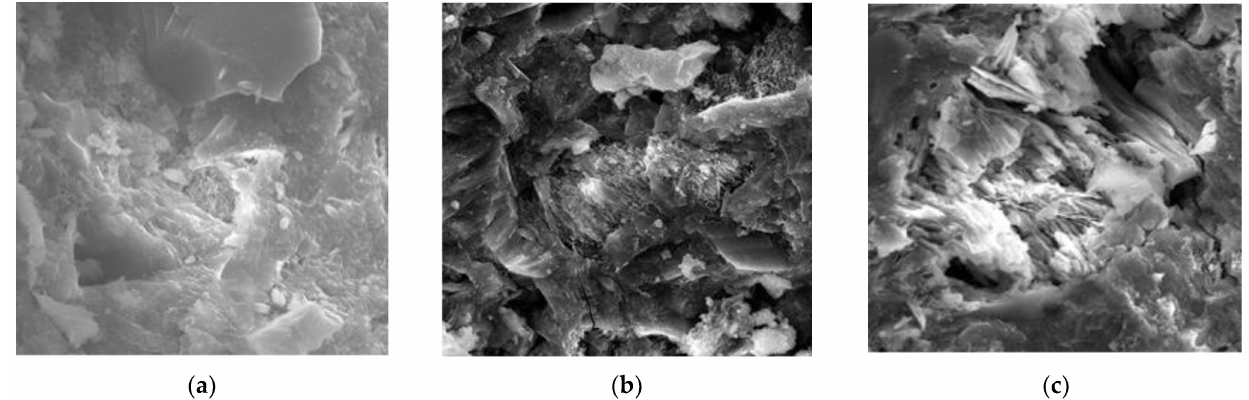
Figure 2. SEM morphology of cement-based materials under different rehydration periods [40]. ( a ) Rehydration for 28 days; ( b ) rehydration for 56 days; ( c ) rehydration for 180